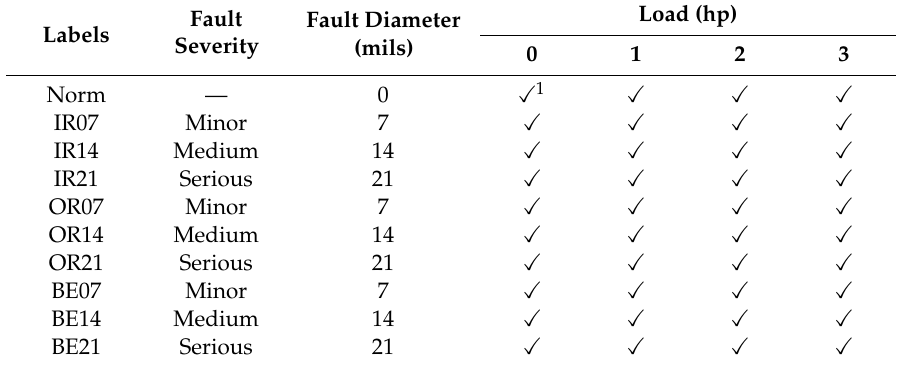
Table 2. Experimental sample distribution under different load conditions of the rolling bearing.